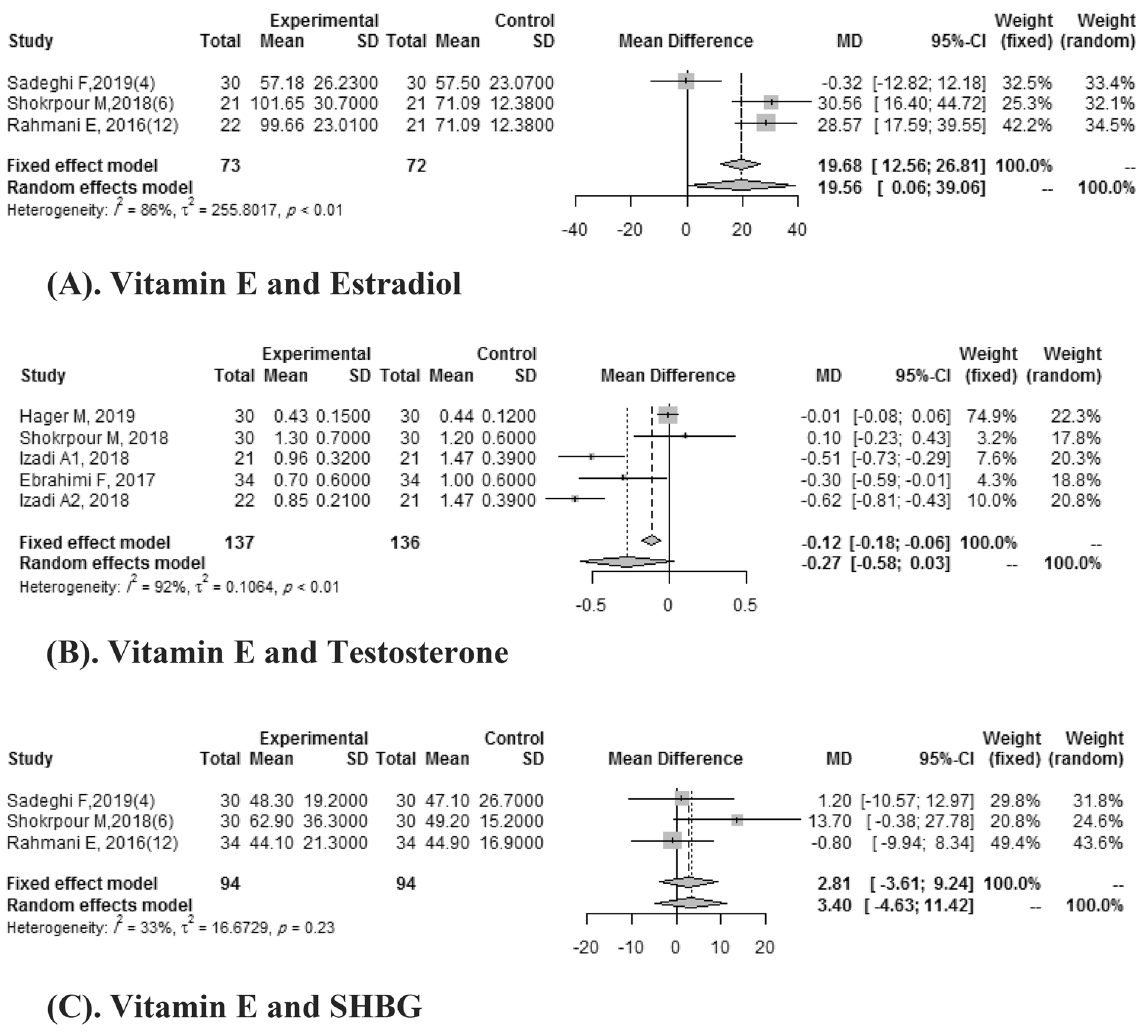
Figure 5. ( A ) Vitamin E and estradiol. ( B ) Vitamin E and testosterone. ( C ) Vitamin E and